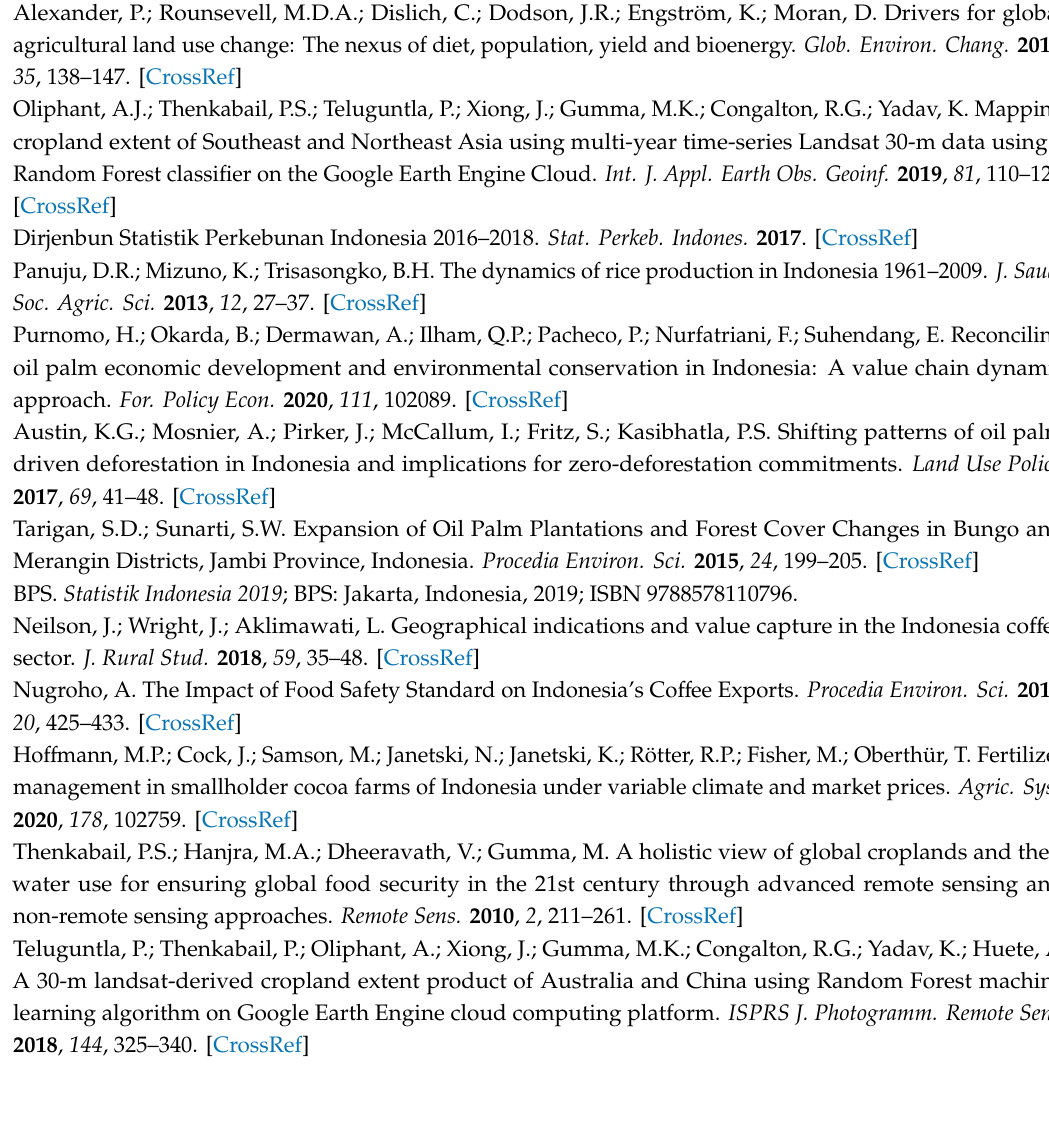
Figure S1: The importance of input variables for the commodity maps by mean decrease Gini coe ffi cient values. BX variable represents the spectral value of band X, ND_BX_BY indicates the covariates between band X and band Y. elevation, slope, eastness, northness, and aspect were the topographical variables. change_abs, change_norm, transition, occurrence, max_extent, and seasonality were surface water predictors from JRC. We also used several spectral indices for the predictors—i.e., EVI, SAVI, and IBI., Figure S2: Comparison between provincial reference data (BPS) and our maps by province for (A) oil palm commodity and (B) paddy rice field